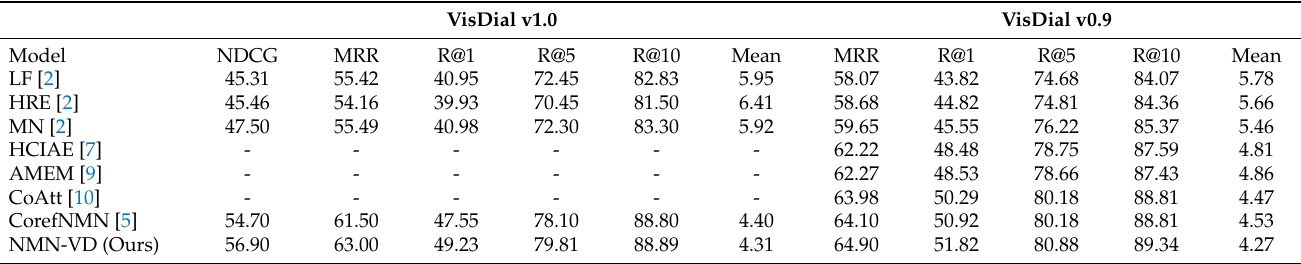
Table 5. Performance comparison with existing